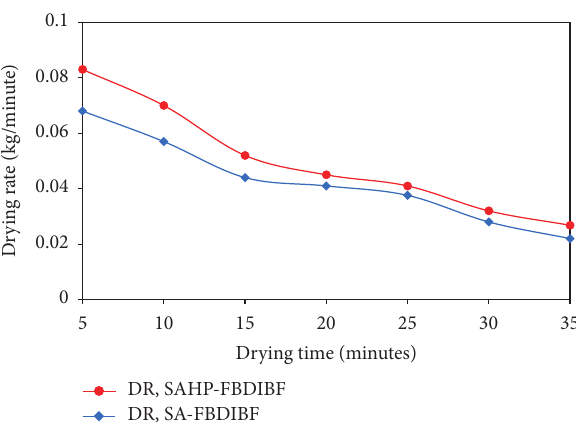
Figure 17: The variation of drying rate with drying time.